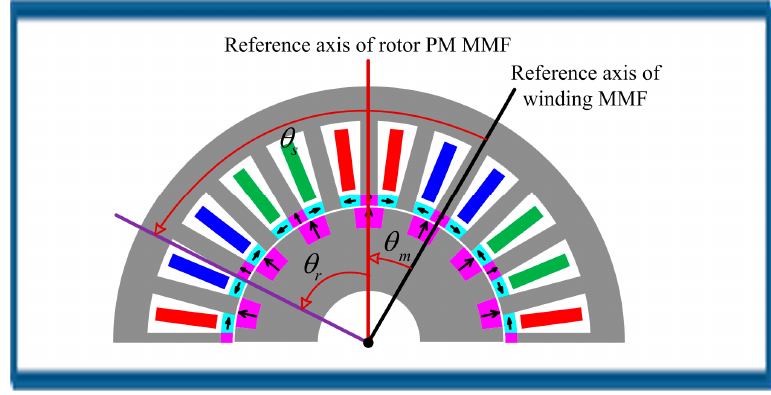
Figure 2. Definition of mechanical angles.